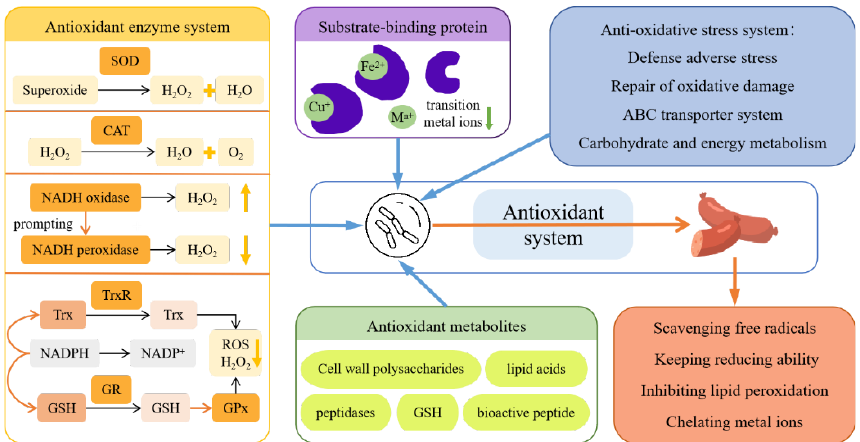
Figure 4. Antioxidant regulation mechanism of LAB. Note: SOD: superoxide dismutase; CAT: catalase; NADH: nicotinamide adenine dinucleotide; Trx: thioredoxin; TrxR: thioredoxin reductase; NADPH: nicotinamide adenine dinucleotide phosphate; GR: glutathione reductase; GSH: glutathione; GPx: glutathione peroxidase.